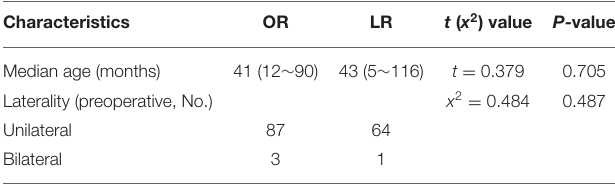
TABLE 1 | Demographic data of the OR and LR groups before